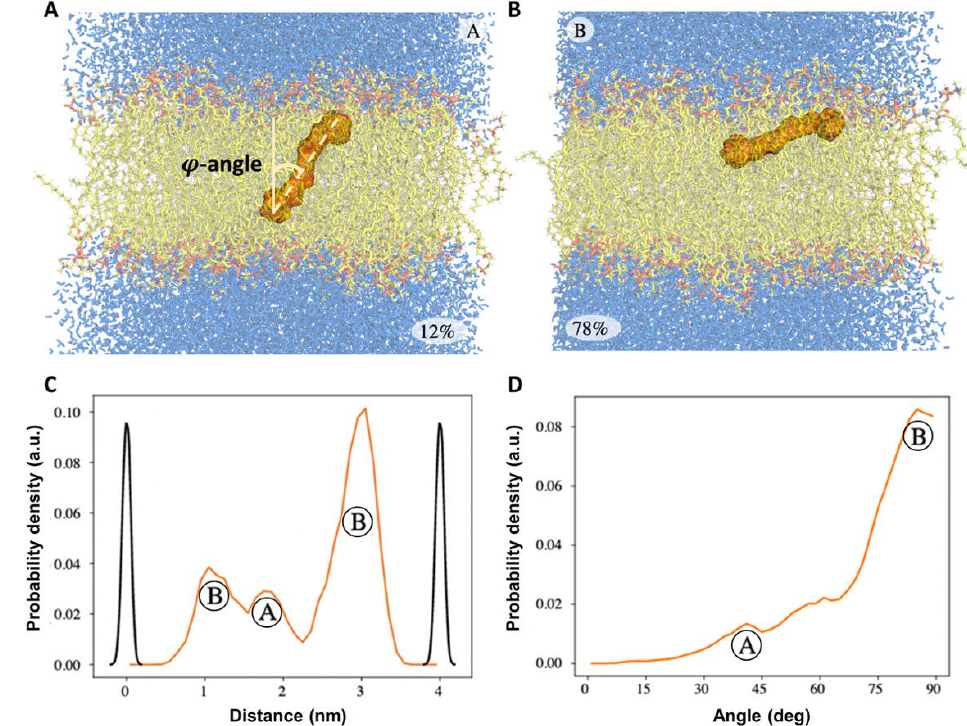
Figure 6. Results of the molecular dynamics simulations of equilibrium localization of β -carotene molecule in bilipid layer. Data was visualized based on the analysis of the trajectory of the center-mass of β -carotene molecule. ( A , B )—possible localizations of β -carotene molecule in the membrane where it occupies either state A (cid:13) ( A ) or state B (cid:13) ( B ) position. State B (cid:13) is more probable, as it was realized for approximately 78% of the simulation time. ( C )—the probability density function (orange-colored curve) for the molecule center of mass localization along the normal to the membrane plane, black-colored curves represent the boarders of the bilipid membrane. ( D )—the probability density function for the angle ϕ between the long axis of the molecule and the normal to the membrane plane.